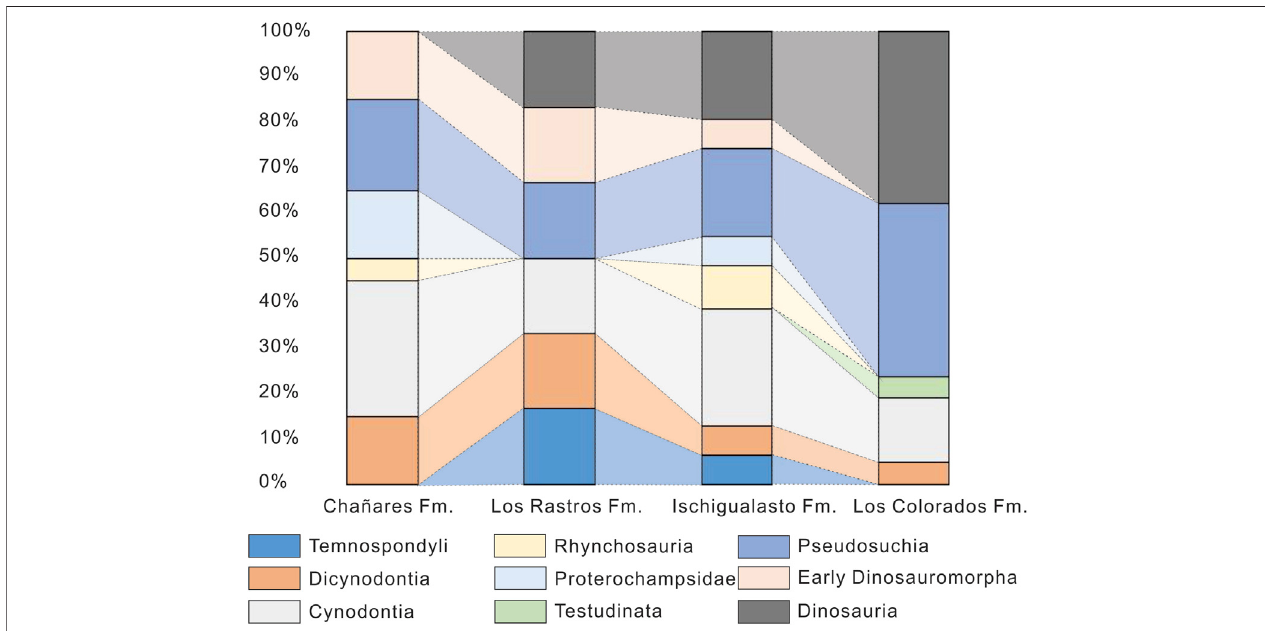
FIGURE 6 | Paleovertebrate record in the units of the Agua de la Peña Group. Percentage of taxa of each taxonomic group registered in each formation.